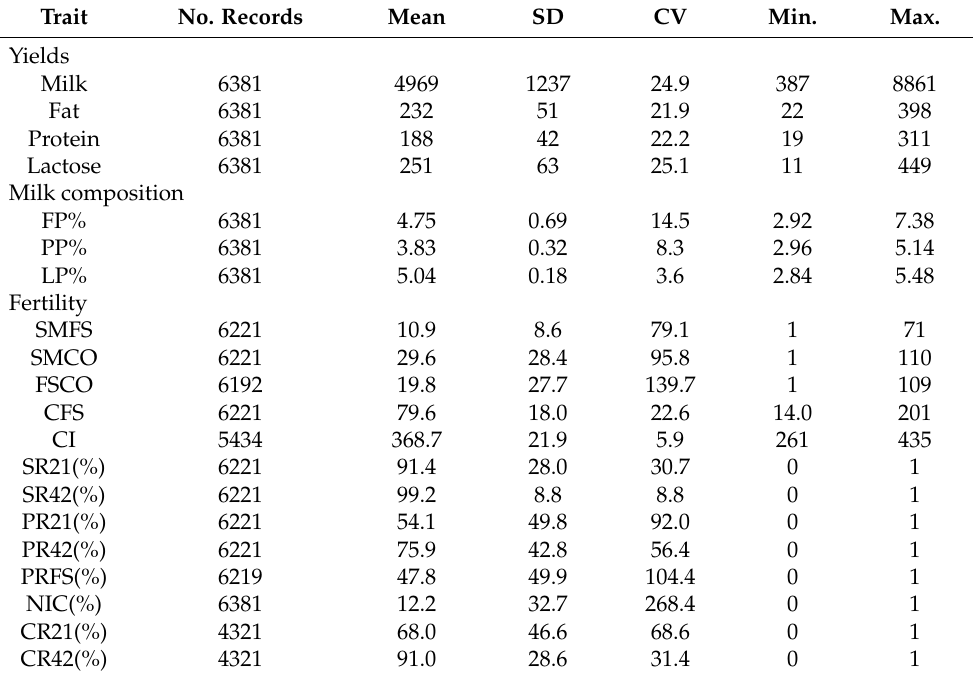
Table 2. Descriptive statistics of milk composition and fertility traits of cows from Massey Dairy 1 and Dairy